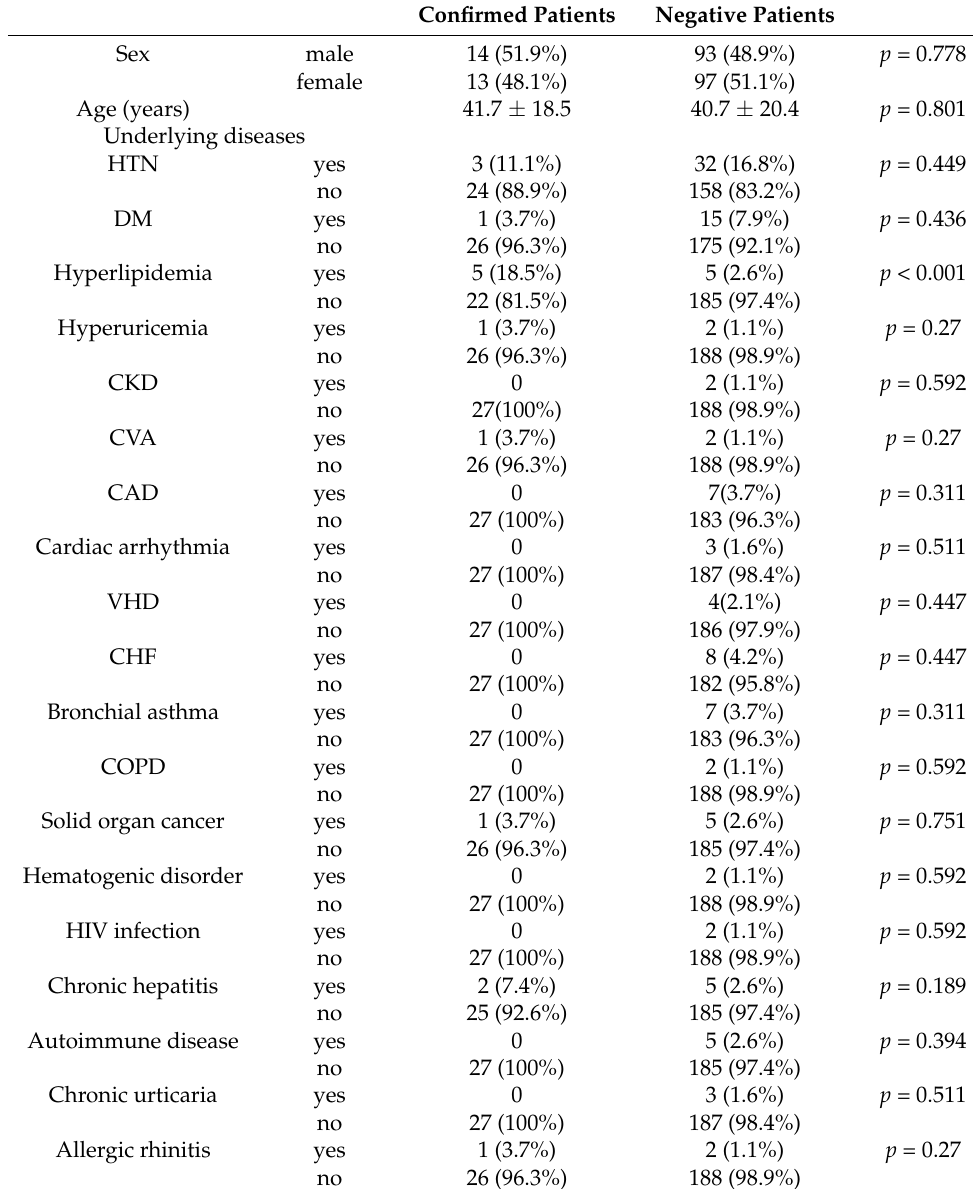
Table 1. Demographic data and underlying diseases of confirmed COVID-19 patients and COVID-19- negative